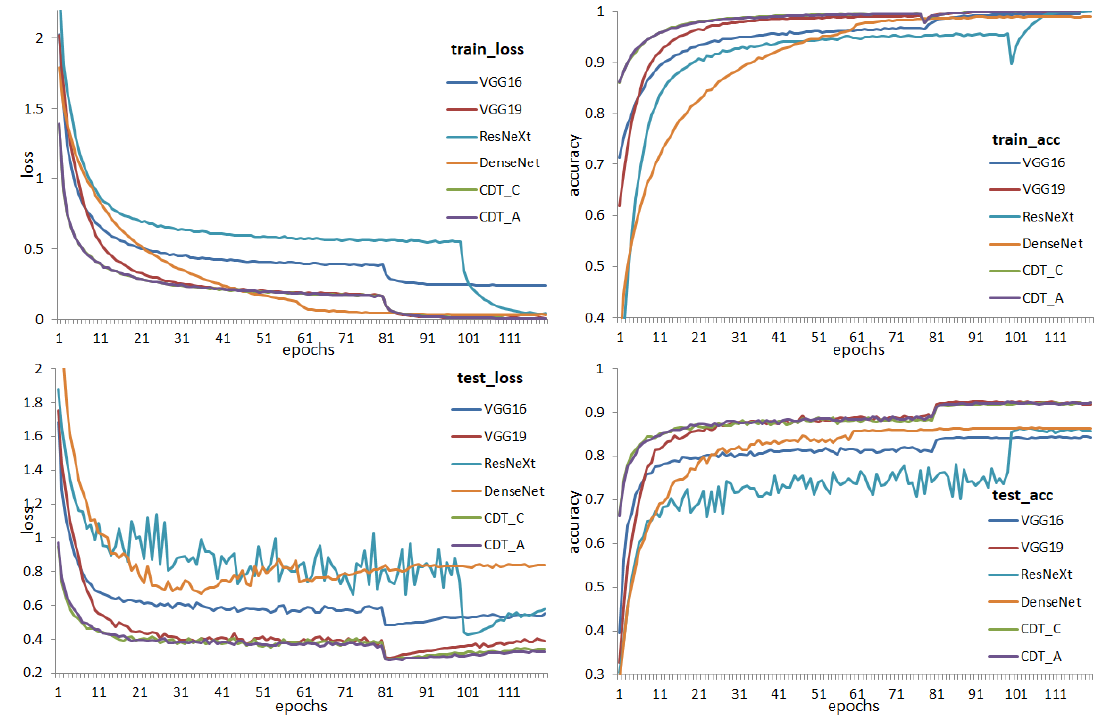
Figure 7. Compared results on CIFAR-10.